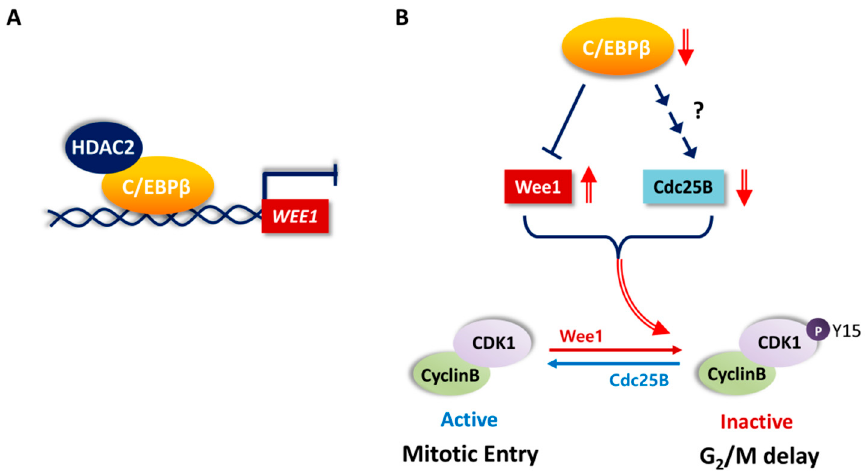
Figure 8. Schematic representation of the potential role of C/EBP β in the G 2 /M phase of cell cycle progression. ( A ) C/EBP β represses WEE1 transcription by directly binding to WEE1 distal promoter regions and recruiting HDAC2. ( B ) Wee1 and Cdc25B are key regulators of phosphorylation of tyrosine 15 residue of CDK1, which blocks mitotic entry. C/EBP β activates Cdc25B expression via unknown mechanism but inhibits Wee1 expression. In the absence of C/EBP β , cells undergo G 2 /M delay displaying increased CDK1 phsophorylation along with increased Wee1 and decreased Cdc25B levels.